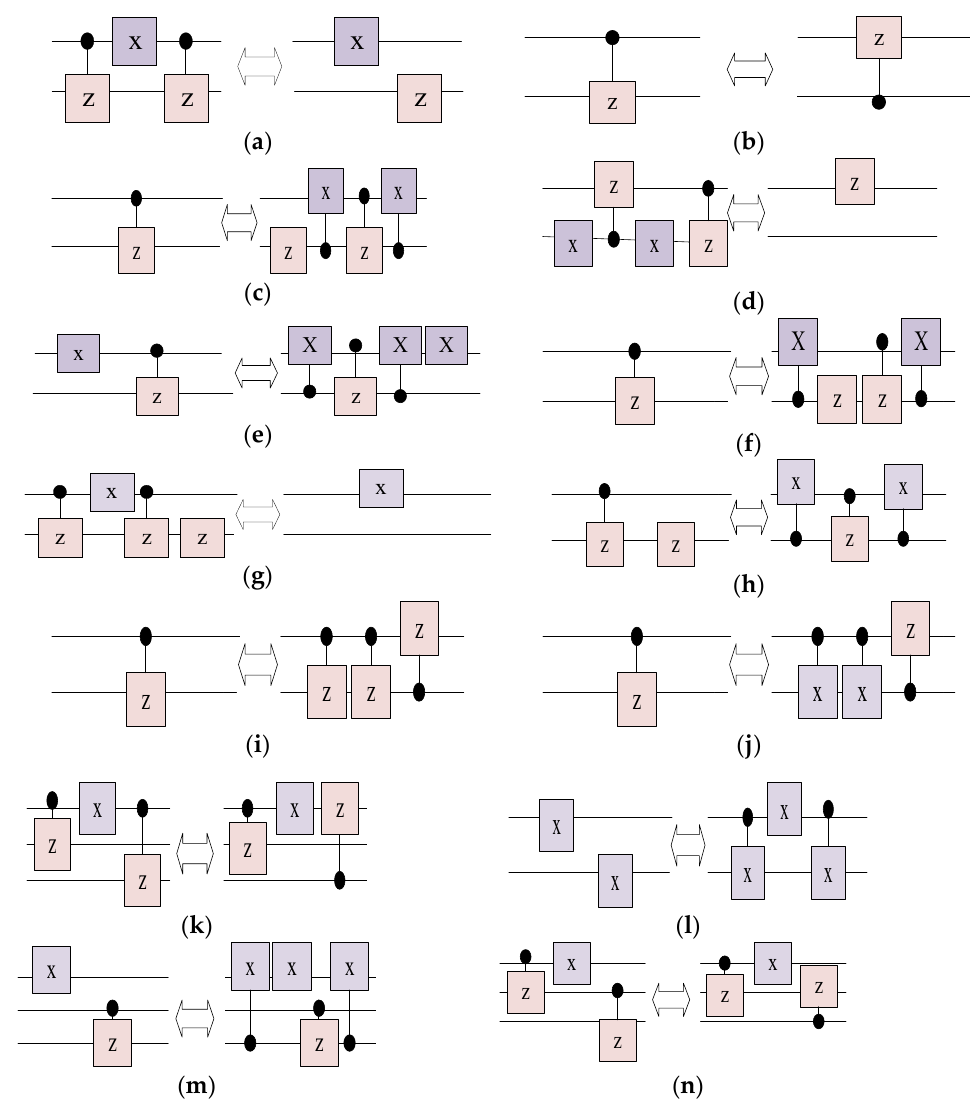
Figure 1. Transformation rules used in this paper. (a): (b): (c): (d): (e): (f) circuitOptimized Gate-Level Netlist Mapping by [11]